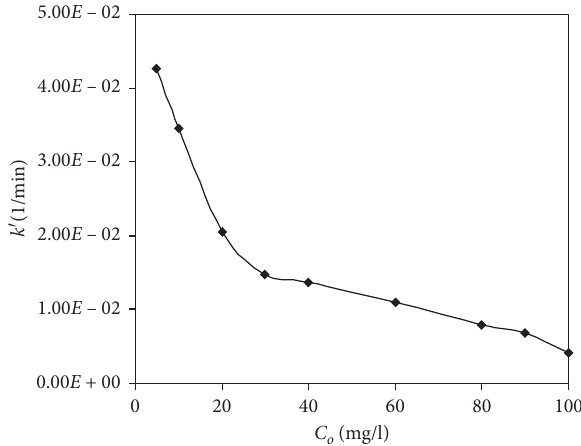
Figure 13: The apparent rate constant k ’ as a function of initial concentrations of RhB.